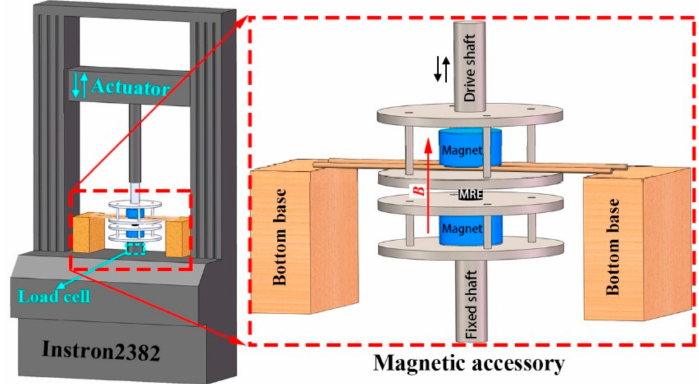
Figure 1. Compression experimental